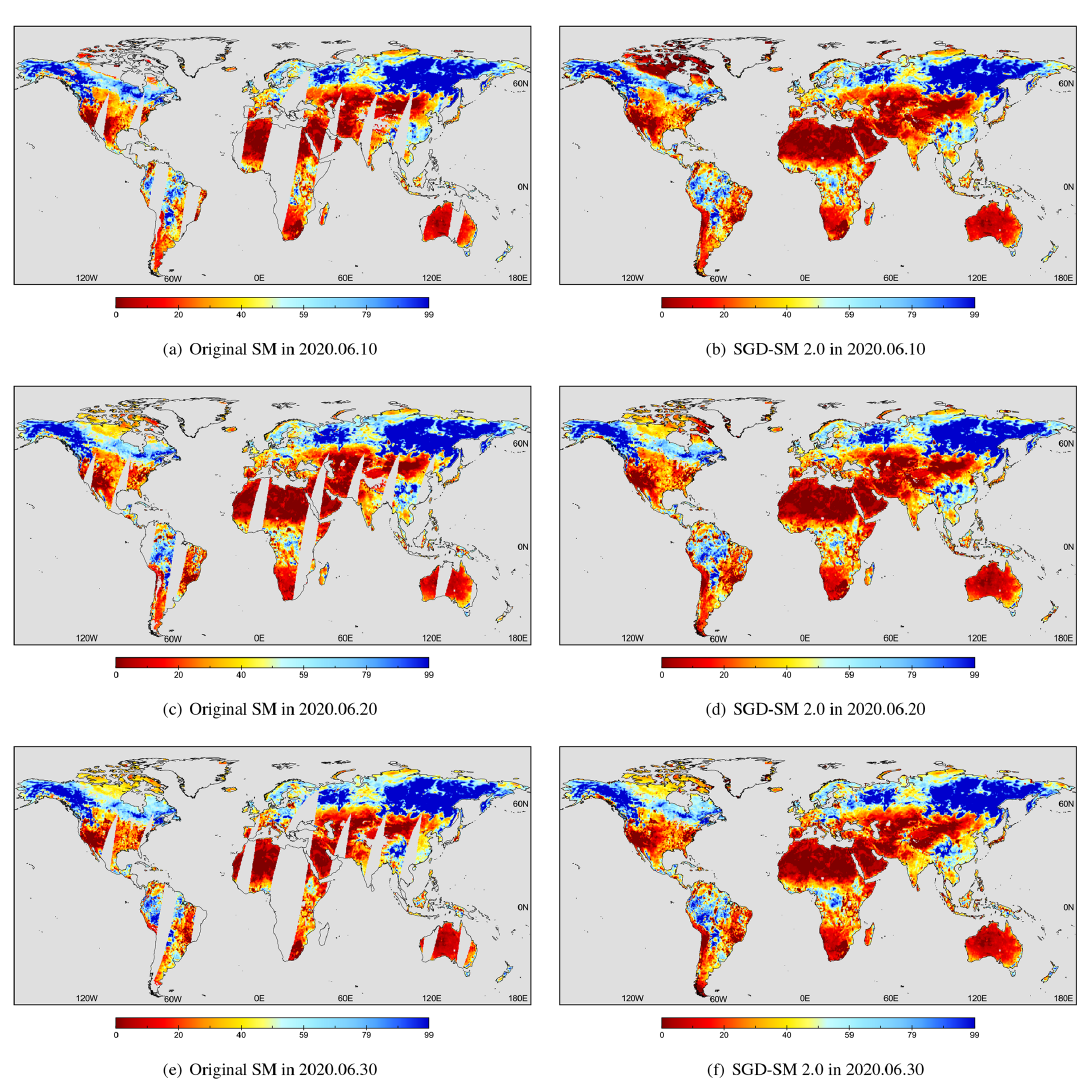
in original and SGD-SM 2.0 products. The horizontal coordi- nate denotes the annual date number between 2003 and